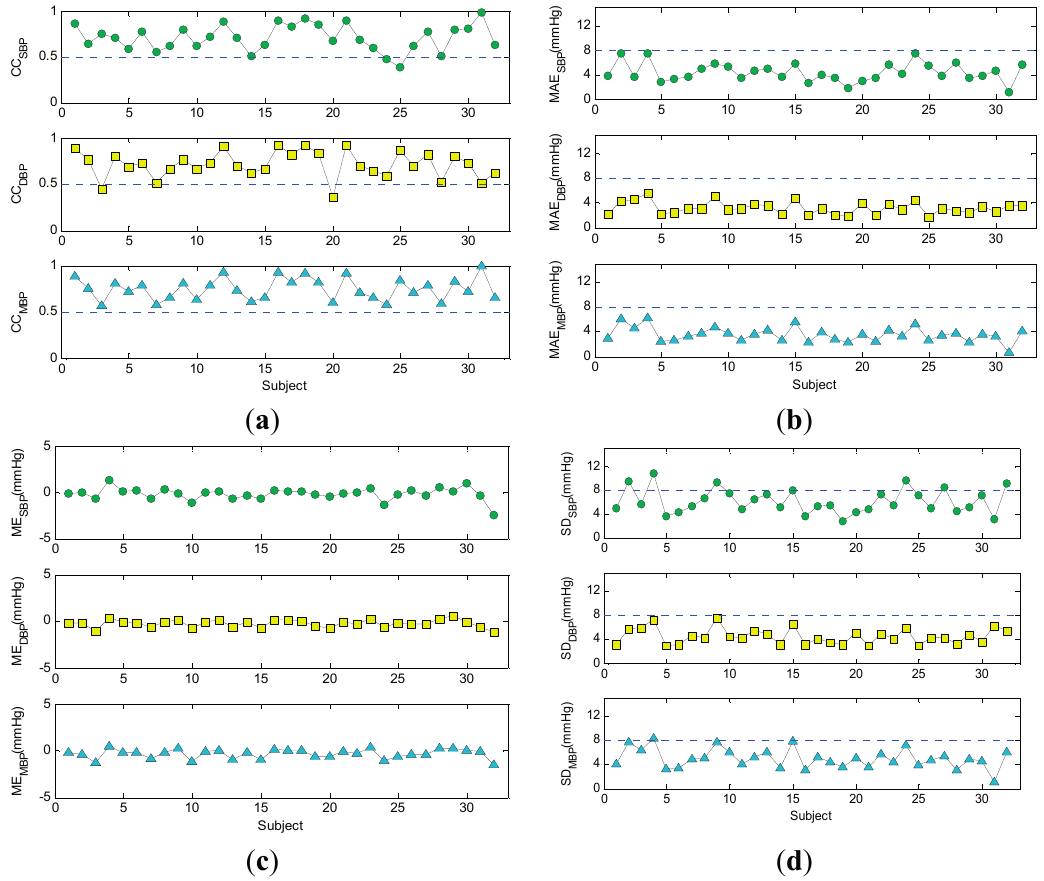
Figure 8. Comparison of predicted values and measured values for each subject. ( a ) Correlation coefficients (CC); The presented data were all statistically significant ( p < 0.05); ( b ) Mean absolute error (MAE); ( c ) Mean error (ME); ( d ) Standard deviation (SD). SBP, systolic blood pressure; DBP, diastolic blood pressure; MBP, mean blood